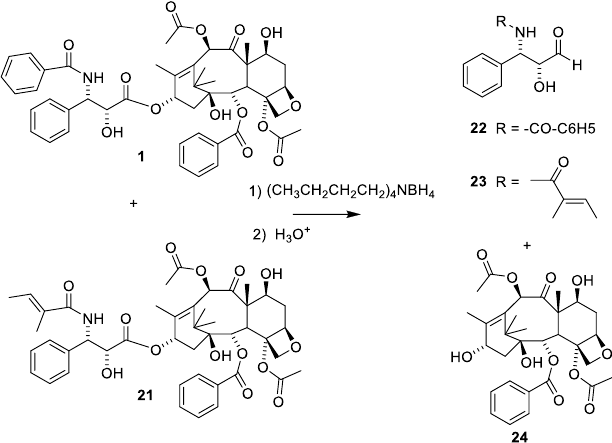
Figure 8. Reductive de-esterification of paclitaxel ( 10 ) and cephalomannine ( 21 ) [47].